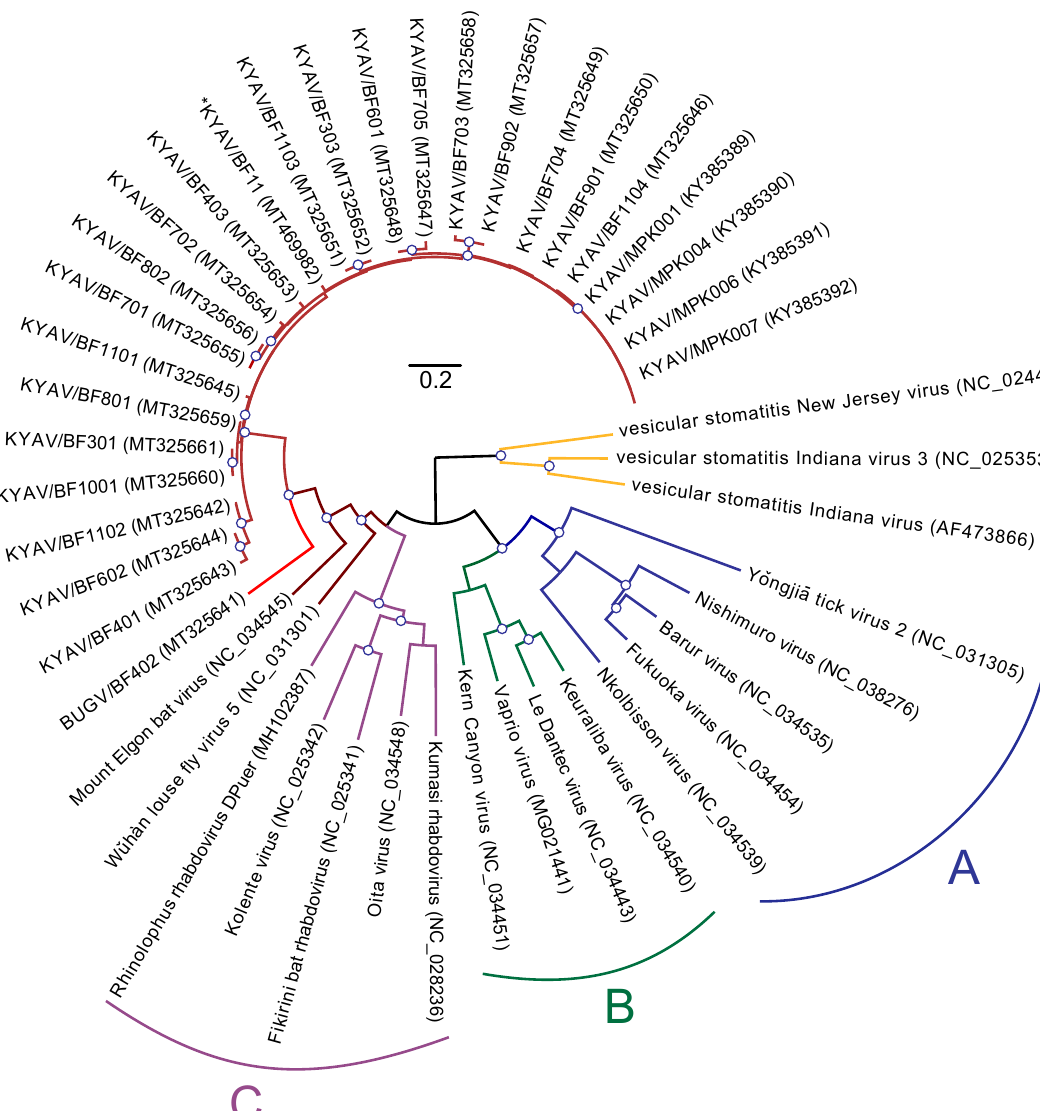
Figure 1. Maximum likelihood tree of the ledantevirus large protein ( L ) gene. Maximum likelihood phylogenetic tree of genus Ledantevirus ( Mononegavirales : Rhabdoviridae ) with 3 members of the neighboring Vesiculovirus genus as an outgroup (yellow). The tree was constructed from a conserved 270-nt sequence of the RNA-directed RNA polymerase domain of the large protein (L), with molecular evolution model selection (GTR + Γ + I) by PhyML smart model selection (Akaike information criterion). Canonical ledantevirus subgroups are highlighted in blue (Subgroup A ), green (Subgroup B ), and purple (Subgroup C ), although Mount Elgon Bat virus, historically of Subgroup C, is included in a monophyletic (red) clade with the hippoboscoid fly ledanteviruses (Kanyawara virus, Bughendera virus, and W ǔ hàn louse fly virus 5). Asterisk indicates sequence from bat oral swab. Circles on nodes indicate > 85% confidence based on 1000 bootstrap replicates. Scale bar indicates nucleotide substitutions per site.